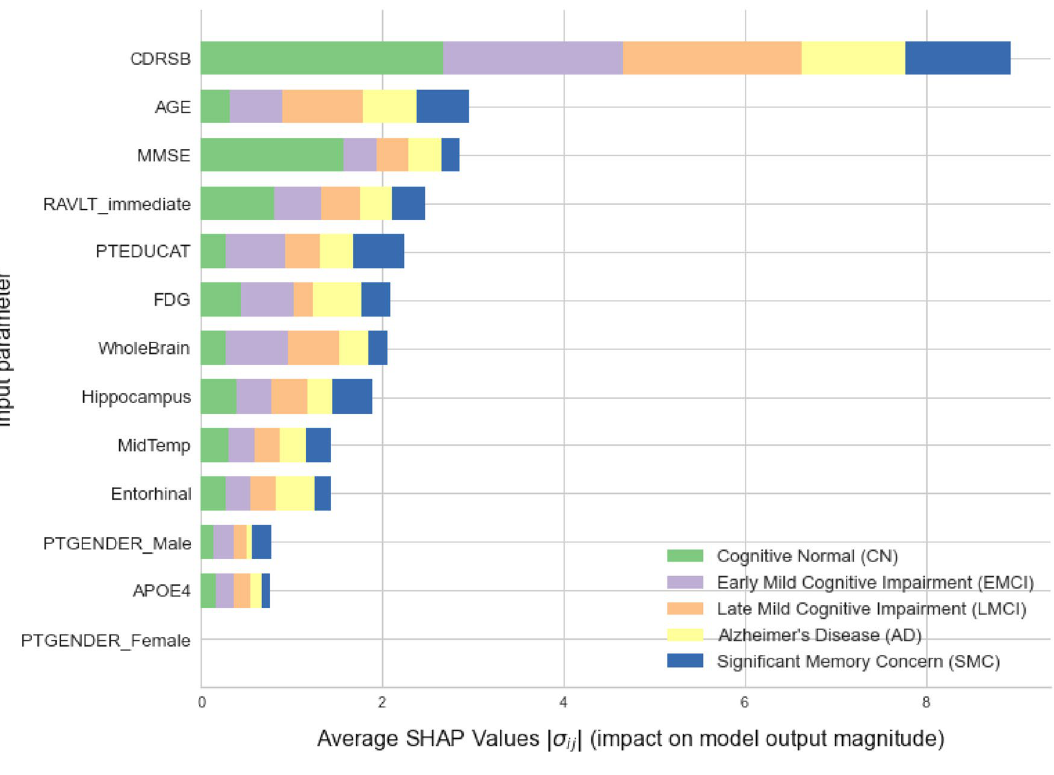
Figure 10. Summary variables importance plot for XGBoost